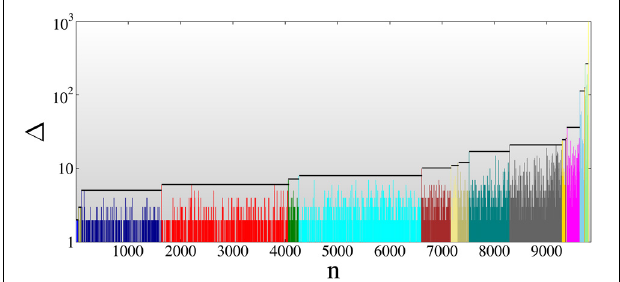
FIGURE 1 | Time series of bursts in a mean field (ELS) simulation of the FBM of creep. For demonstration purposes a relatively small system N = 10 5 is presented at the load σ s = 0 . 001 giving rise to 9793 avalanches. In order to have a clear view on the structure of the time series, sub-sequences starting at record breaking events are highlighted by different colors. The horizontal lines serve to demonstrate the increments between consecutive record